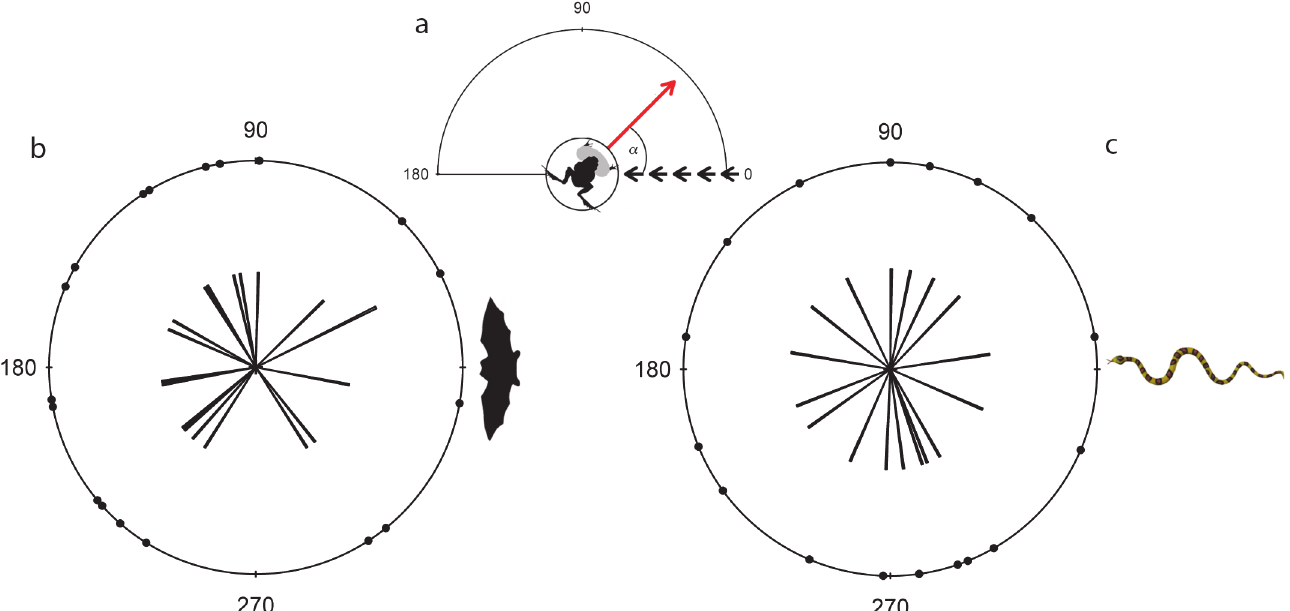
Fig 1. Circular distribution of the directions each frog faced immediately prior to onset of trial. (a) Schematic illustrates the method used to measure the initial frog orientation relative to the predator model ’ s direction of approach; Short black arrows indicate trajectory of predator approach at 0°; Long arrow indicates prey orientation while angle α indicates the prey ’ s angle of deviation from the predator approach. Orientation angle distribution of frogs presented with bat (b) and snake (c) models was random for both